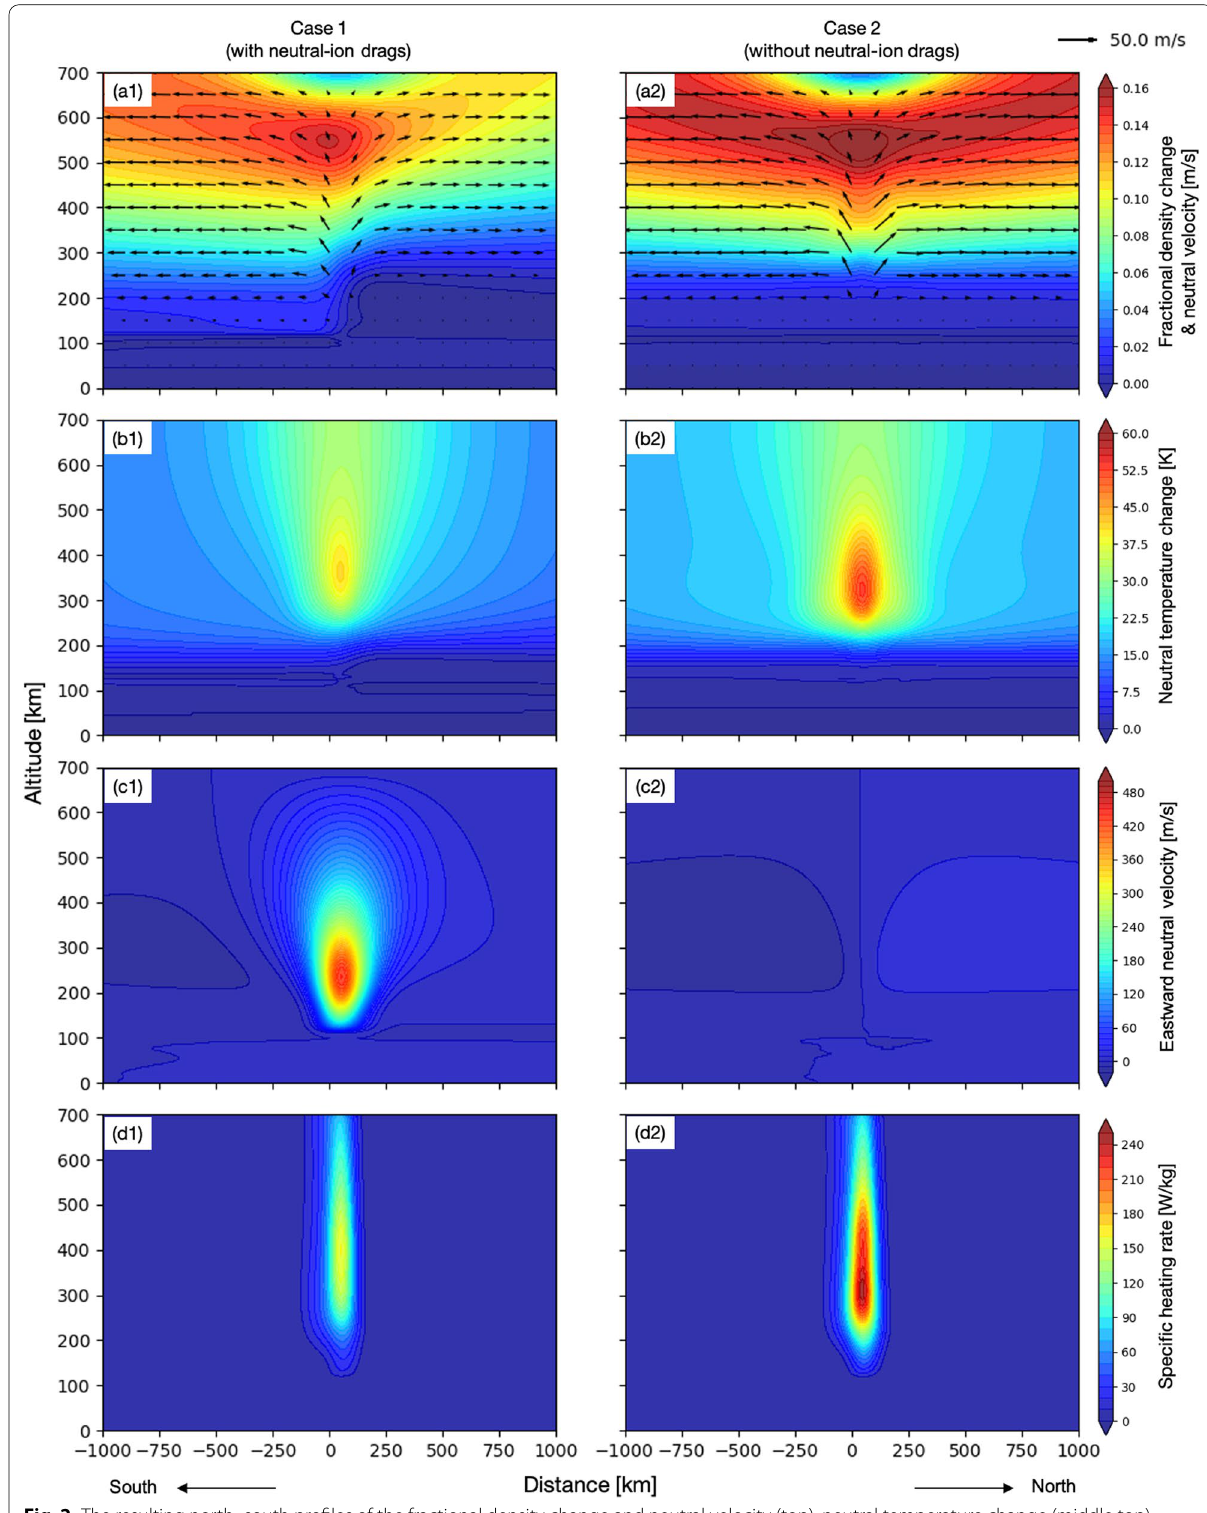
Fig. 2 The resulting north–south profiles of the fractional density change and neutral velocity (top), neutral temperature change (middle top), eastward neutral velocity (middle bottom), and specific heating rate (bottom) in each case. In the top, the contour maps show the fractional density change, and vectors show the neutral flow velocity. The right side (positive values) of the horizontal axis is the north. The peak of electron precipitation is located at the horizontal